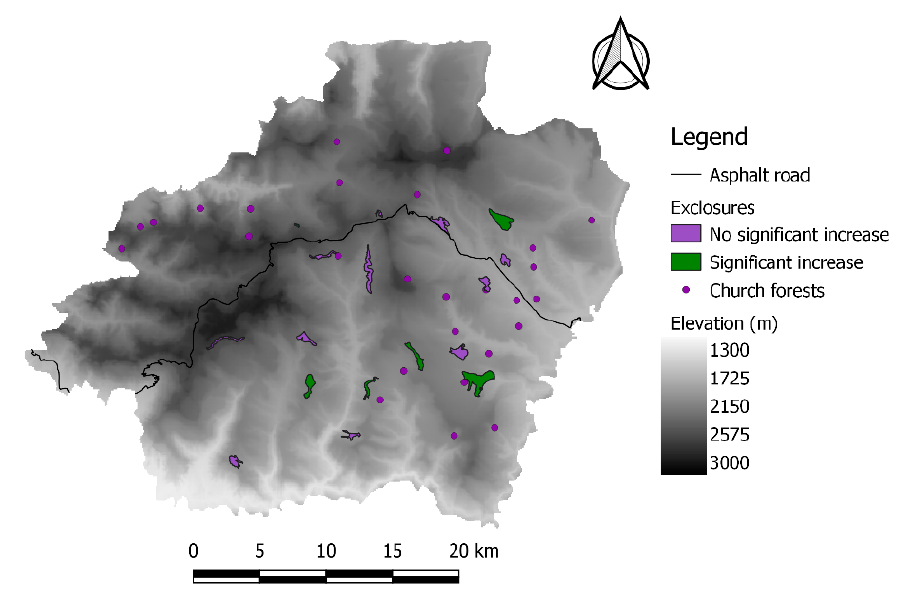
Figure A6. Elevation of the Degua Tembien district, together with the location of the 17 exclosures and 25 church forests included in the analysis.